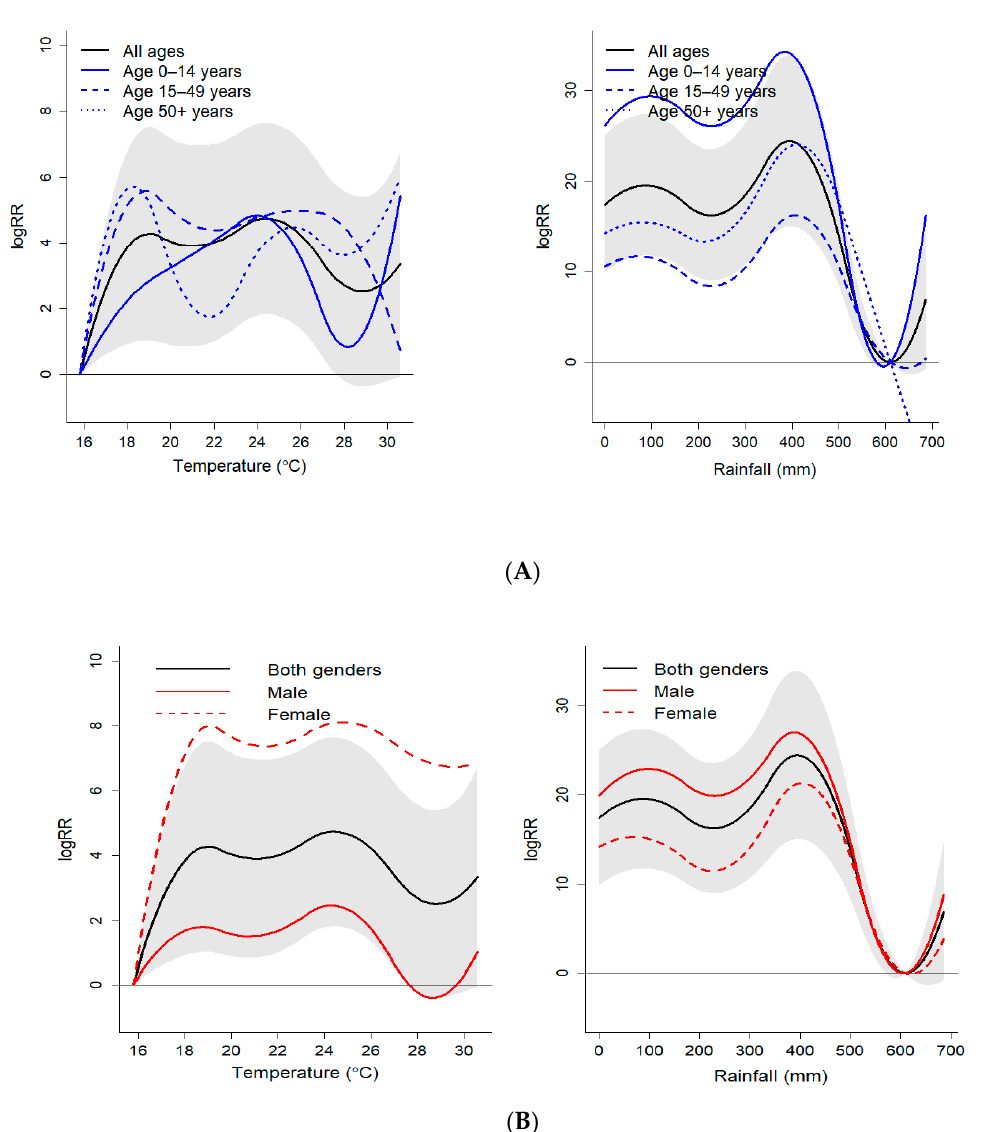
Figure 4. Overall association (relative risk) of temperature exposures with malaria over 0–15 lag weeks, by ( A ) age group and ( B ) gender in the study period. The grey shaded area represents the 95% CI for the estimated logRR for combined data (black line). The logRR are estimated with reference to 15.8 ◦ C mean temperature and 609 mm of